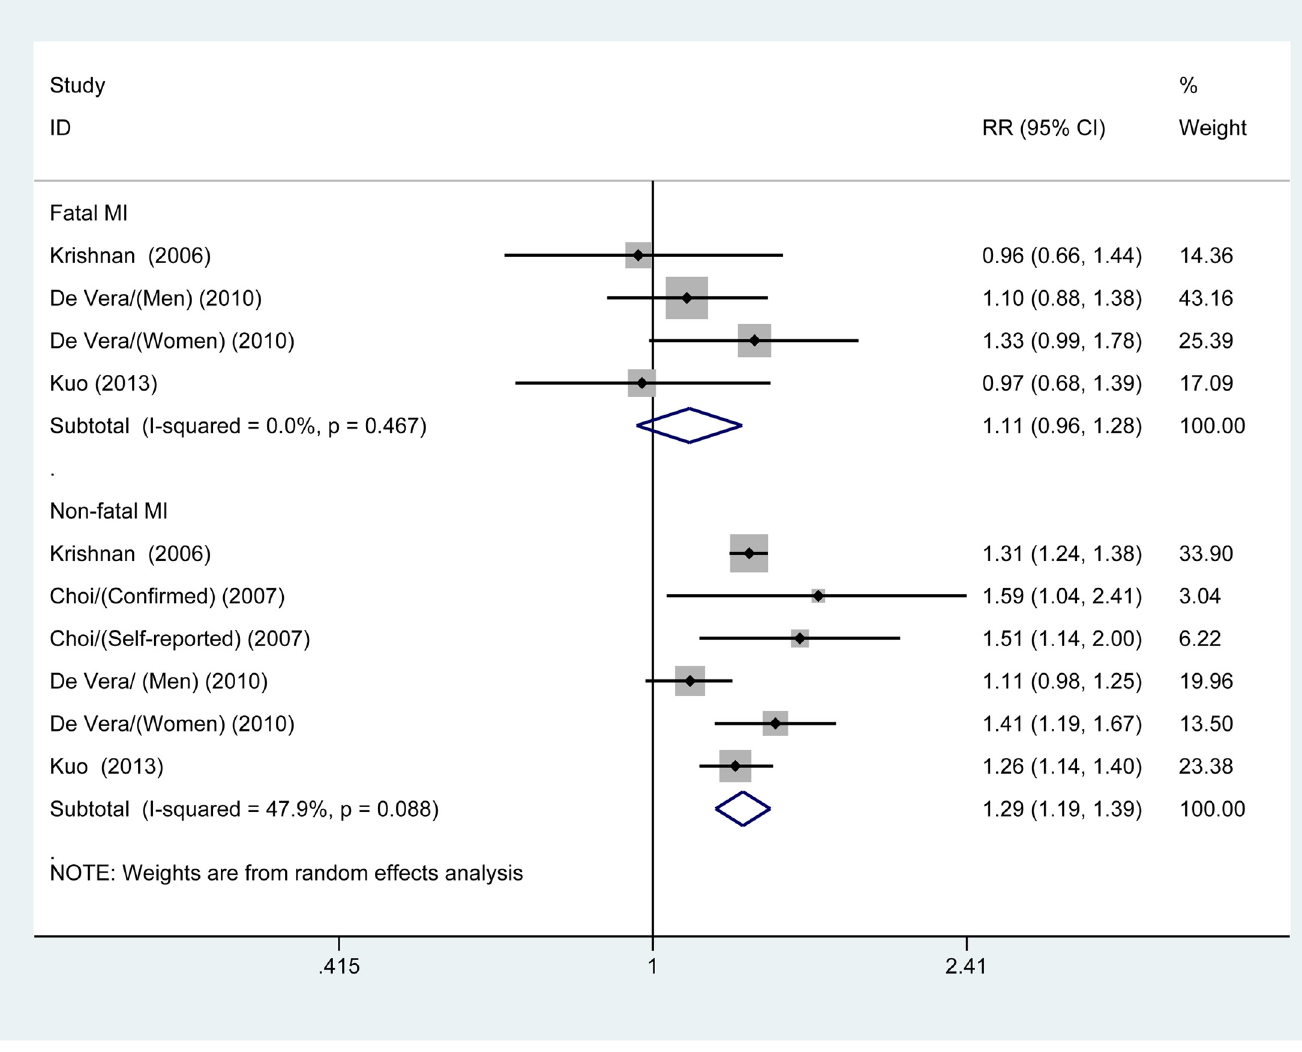
Fig 3. Meta-analysis of the association between gout and different kinds of myocardial infarction (MI; fatal MI and non-fatal MI).